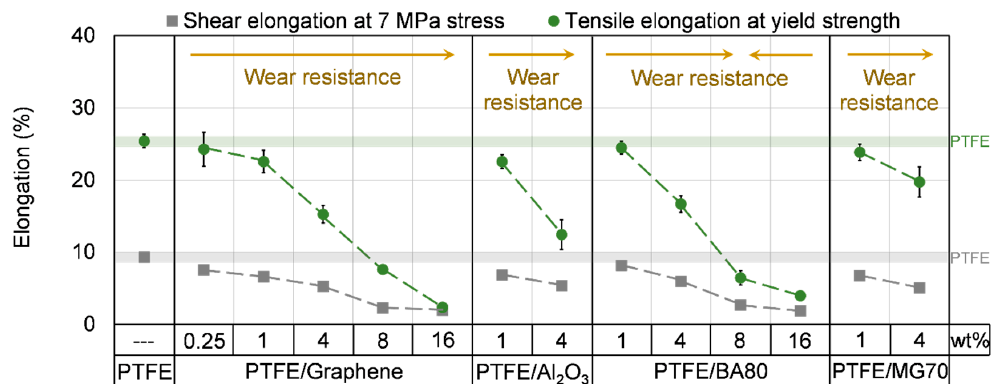
Figure 8. Compressive, shear and tensile modulus of unfilled and filled PTFE samples. The blue, grey and green transparent lines display the compressive, shear and tensile modulus of neat PTFE, respectively.